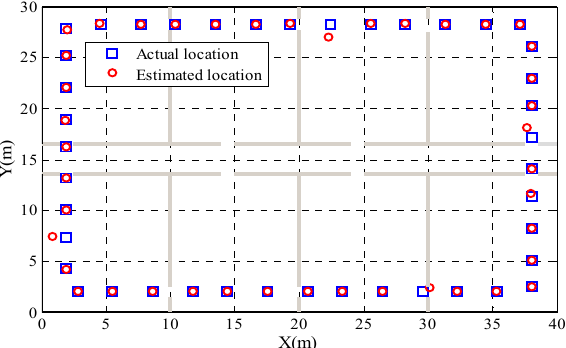
Figure 23. Actual and estimated locations for indoor NLOS environments.